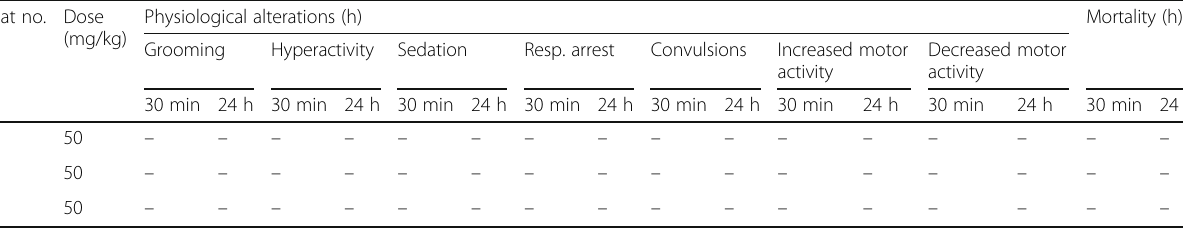
Table 1 The acute toxicity test of the commercial hair dye X at a dose of 50 mg/kg Rat no. Dose Physiological alterations (mg/kg)